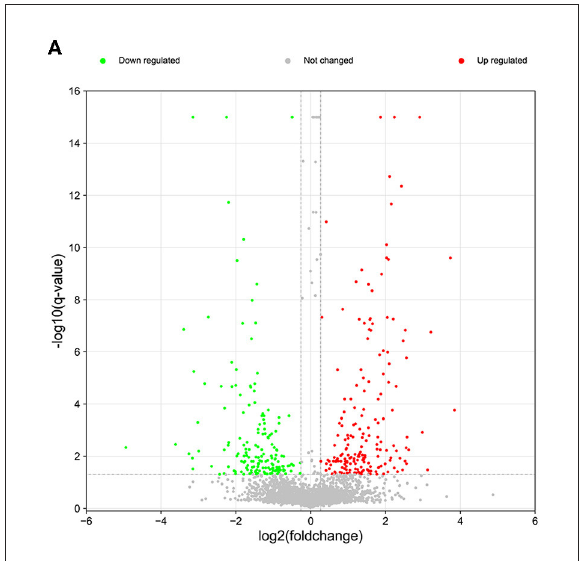
FIGURE2 The volcano plot of differentially expressed and unchanged proteins. Red dots represent the up-regulated proteins and green dots denote the down-regulated